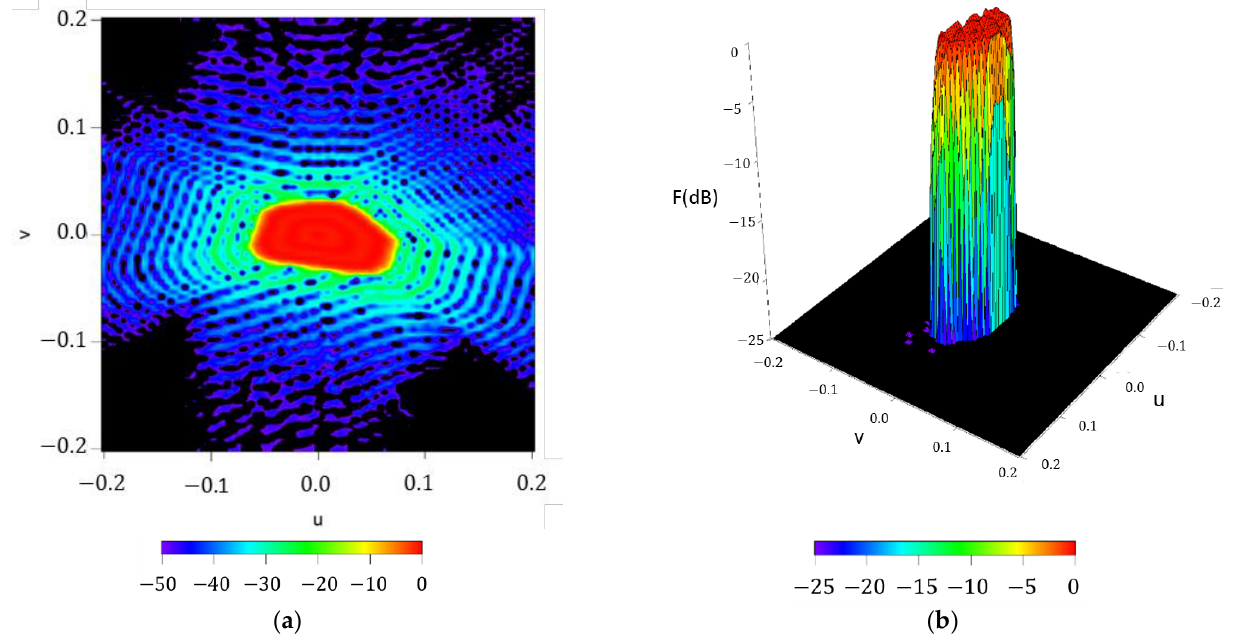
Figure 13. Reconstructed pattern of the required footprint for the case of the continental Europe footprint by means of the obtained Fourier coefficients in (2): ( a ) interpolated image with a threshold level set at − 50 dB; ( b ) surface plot with a threshold level set at − 25